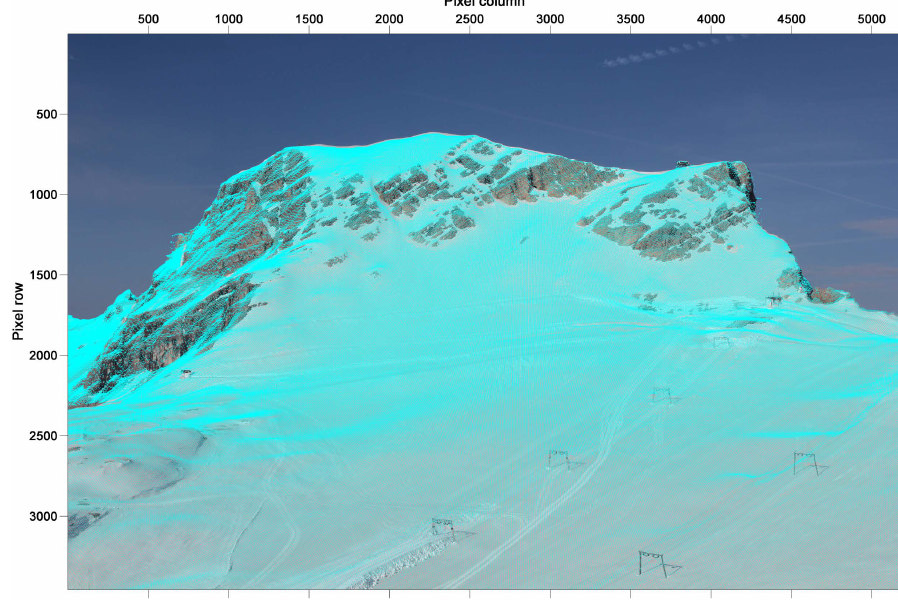
Fig. 6. The georectification of the visible DEM pixels (Fig. 3) is superimposed with cyan dots on the corresponding photograph.